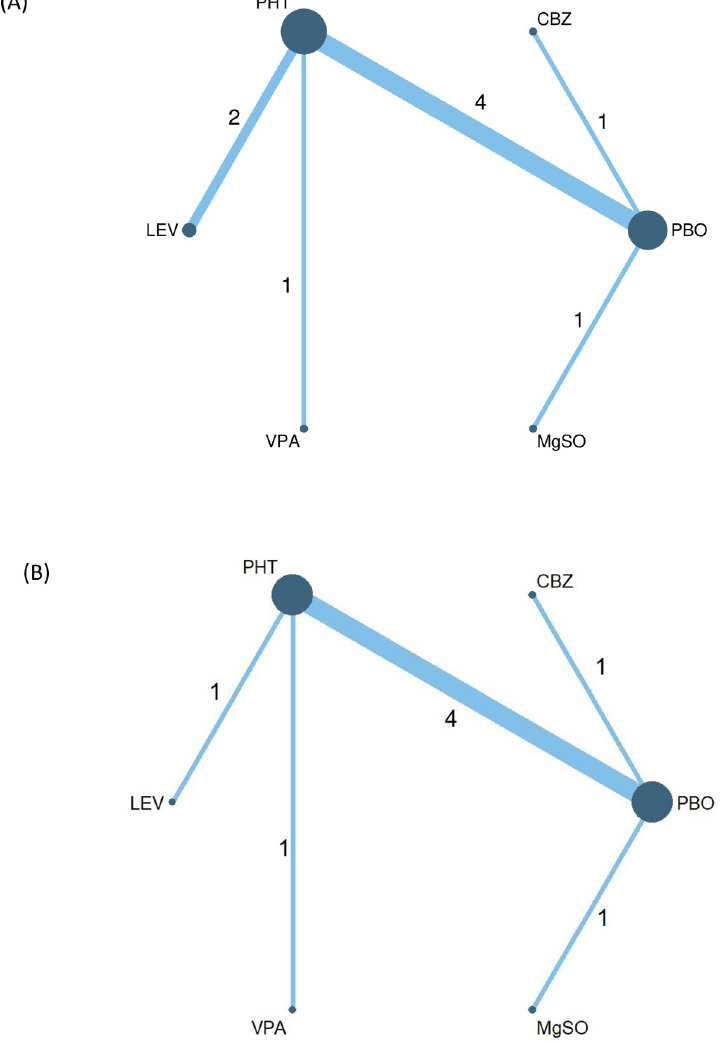
Fig 2. (A). Network maps for comparing different AEDs on preventing early post-traumatic seizures. (B). Network maps for comparing different AEDs on preventing late post-traumatic